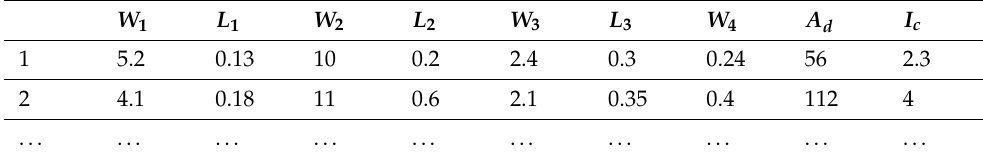
Table 1. An example of a dataset with X i and Y j